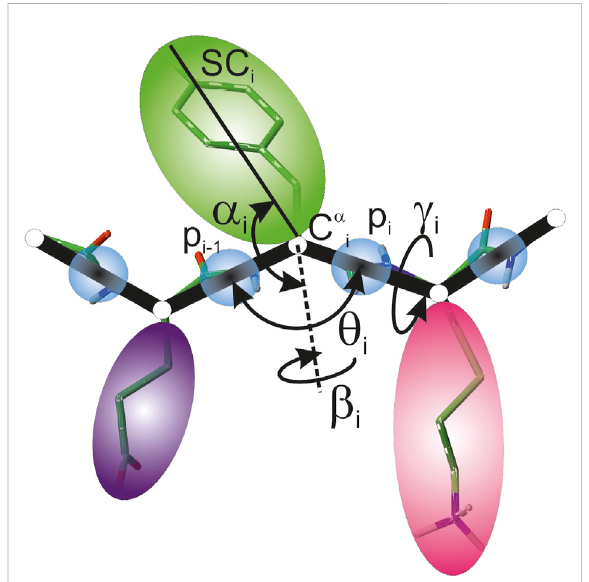
FIGURE 1 UNRES model ofpolypeptidechains. The interaction sitesare united peptide groups located between the consecutive α -carbon atoms (light-blue spheres) and united side chains attached to the α -carbon atoms (spheroids with different colors and dimensions). The backbone geometry of the simpli fi ed polypeptide chain is de fi ned by the C α / C α / C α virtual-bond angles θ ( θ i has the vertex at C α i ) and the C α / C α / C α / C α virtual- bond-dihedral angles γ ( γ i has the axis passing trough C α i and C α i + 1 ). The local geometry of the i th side-chain center is de fi ned by the polar angle α i (the angle between the bisector of the respective angle θ i and the C α i / SC i vector) and the azimuth angle β i (the angle of counter-clockwise rotation of the C α i / SC i vector about the bisector from the C α i − 1 / C α i / C α i + 1 plane, starting from C α i − 1 ). For illustration, the bonds of the all-atom chains, except for those to the hydrogen atoms connected with the carbon atoms, are superposed on the coarse-grained picture. Reproduced with permission from Zaborowski et al., 2015, J. Chem. Inf. Model., 55, 2050 (2015). Copyright 2015 American Chemical